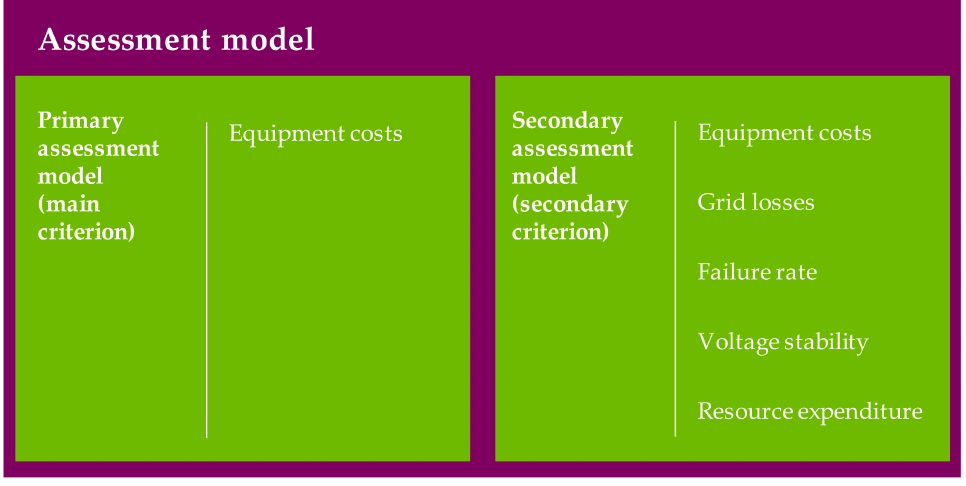
Figure 12. Assessment model with different assessment